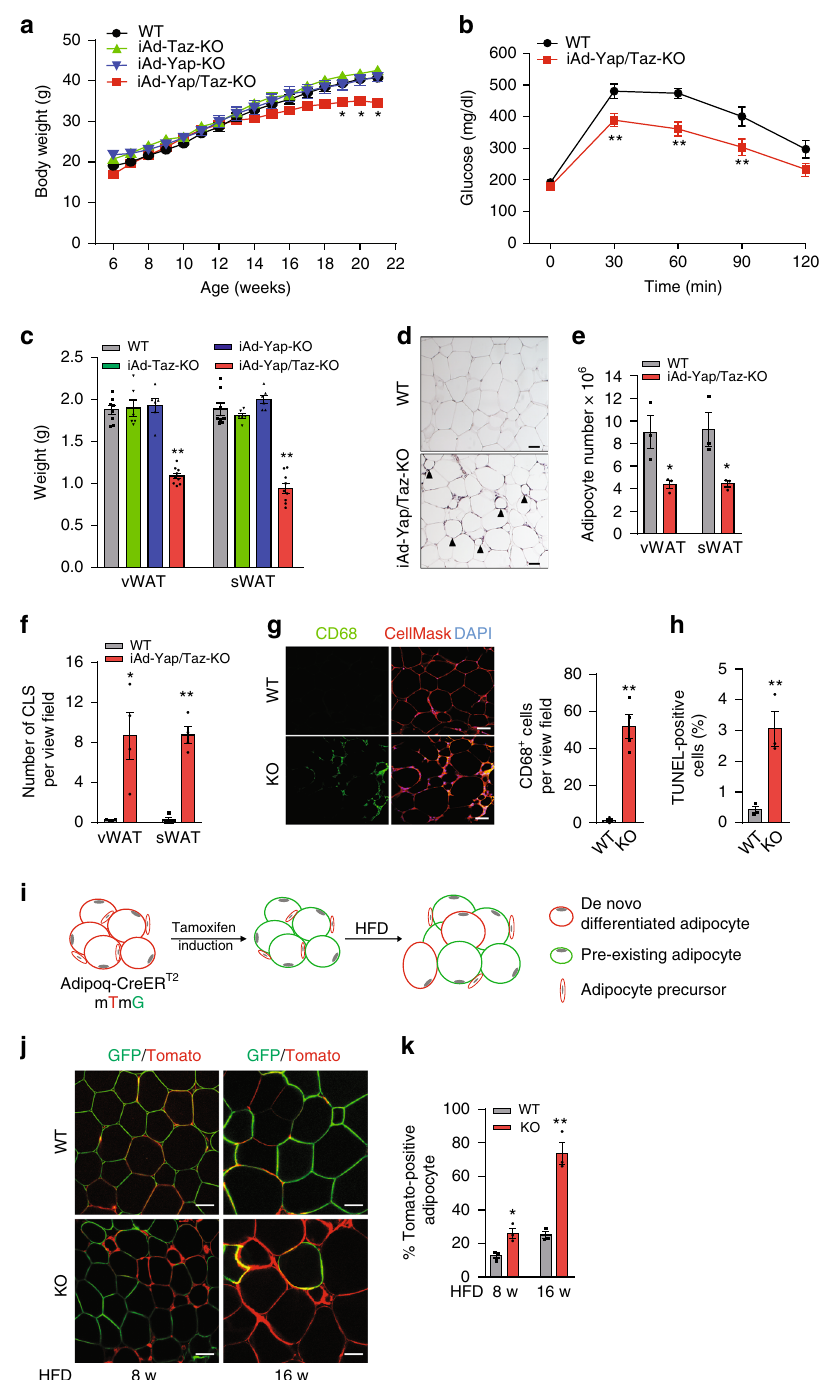
(Fig. 3d, e). After 14 weeks of HFD feeding, Ad-Yap/Taz-KO mice showed a strongly reduced expression of the adipocyte- speci fi c lipid droplet protein perilipin-1, accumulation of mac- rophages, and increased expression of M2 macrophage marker genes including Arg1 , Mrc1 , and IL-10 , whereas expression of M1 marker genes such as iNOS was rather decreased (Fig. 3f –